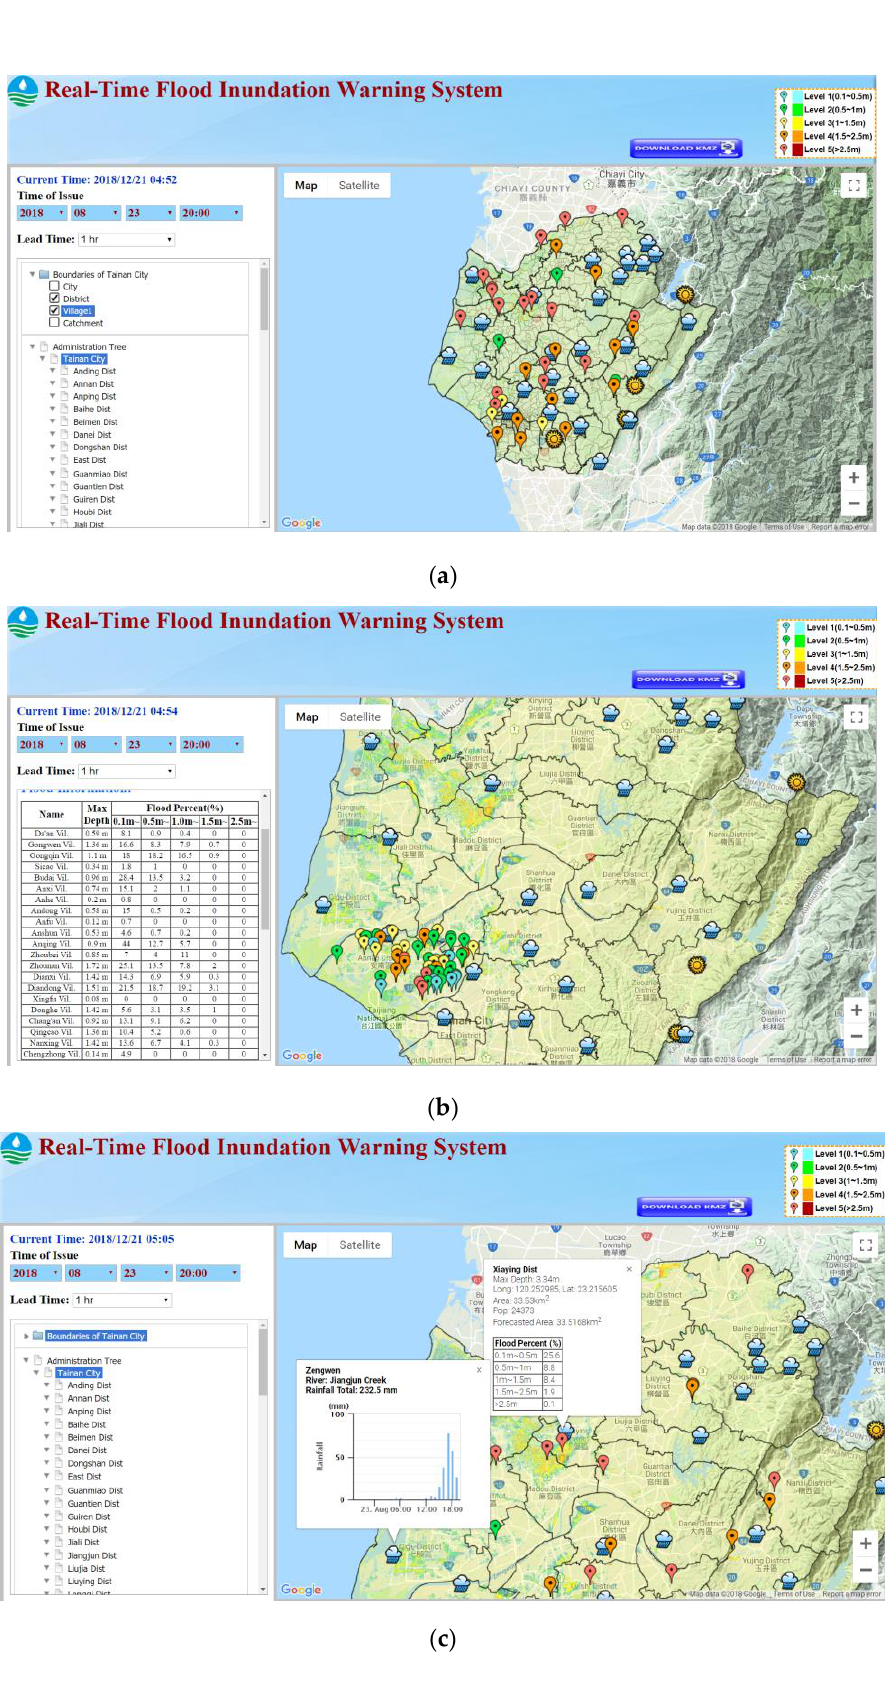
Figure 4. Main functions of the display interface. ( a ) Districts, Villages; ( b ) Table of flood information in selected villages; ( c ) Rainfall information and the maximal flood inundation depths display on Google Map.